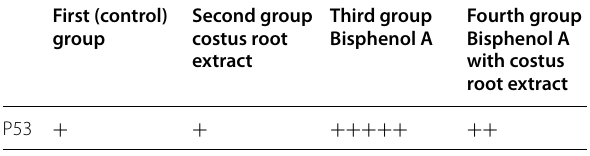
Table 4 Effect of the treatment with Bisphenol A alone or together with costus root extract on immunohistochemical staining for